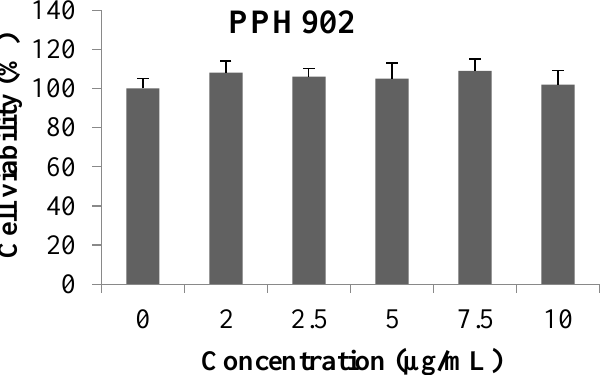
Figure 1. Effect of PPH902 on cell viability of C2C12 cells. Treatment of different concentration of PPH902 in C2C12 did not cause any reduction in their viability.